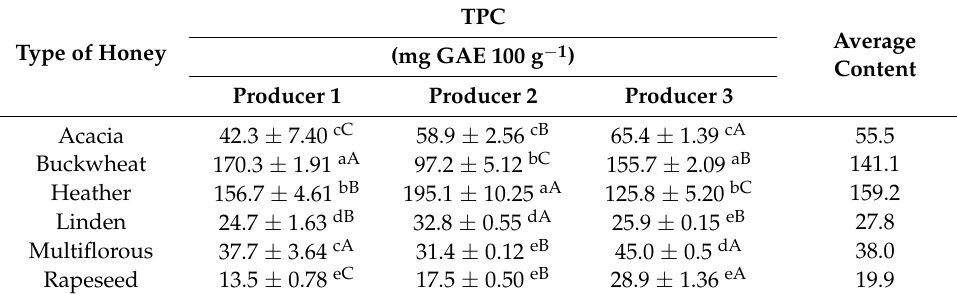
Values are presented as the mean ± standard deviation. a–e Values followed by different letters in the same column